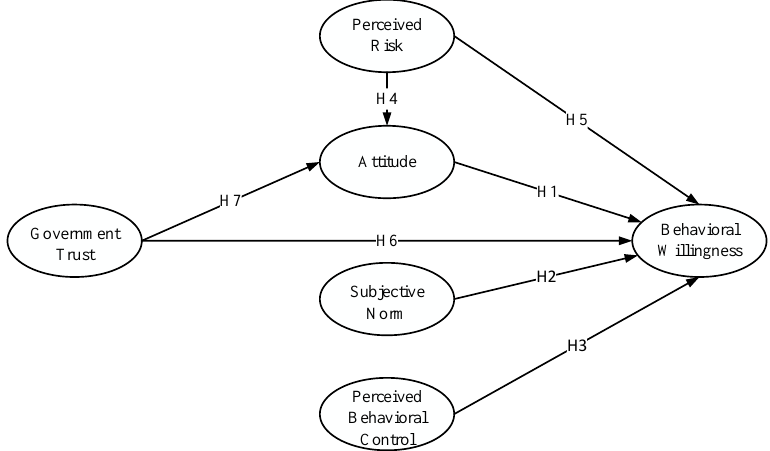
Figure 1. Theoretical model of the extended theory of planned behavior. Table 1. List of abbreviations.